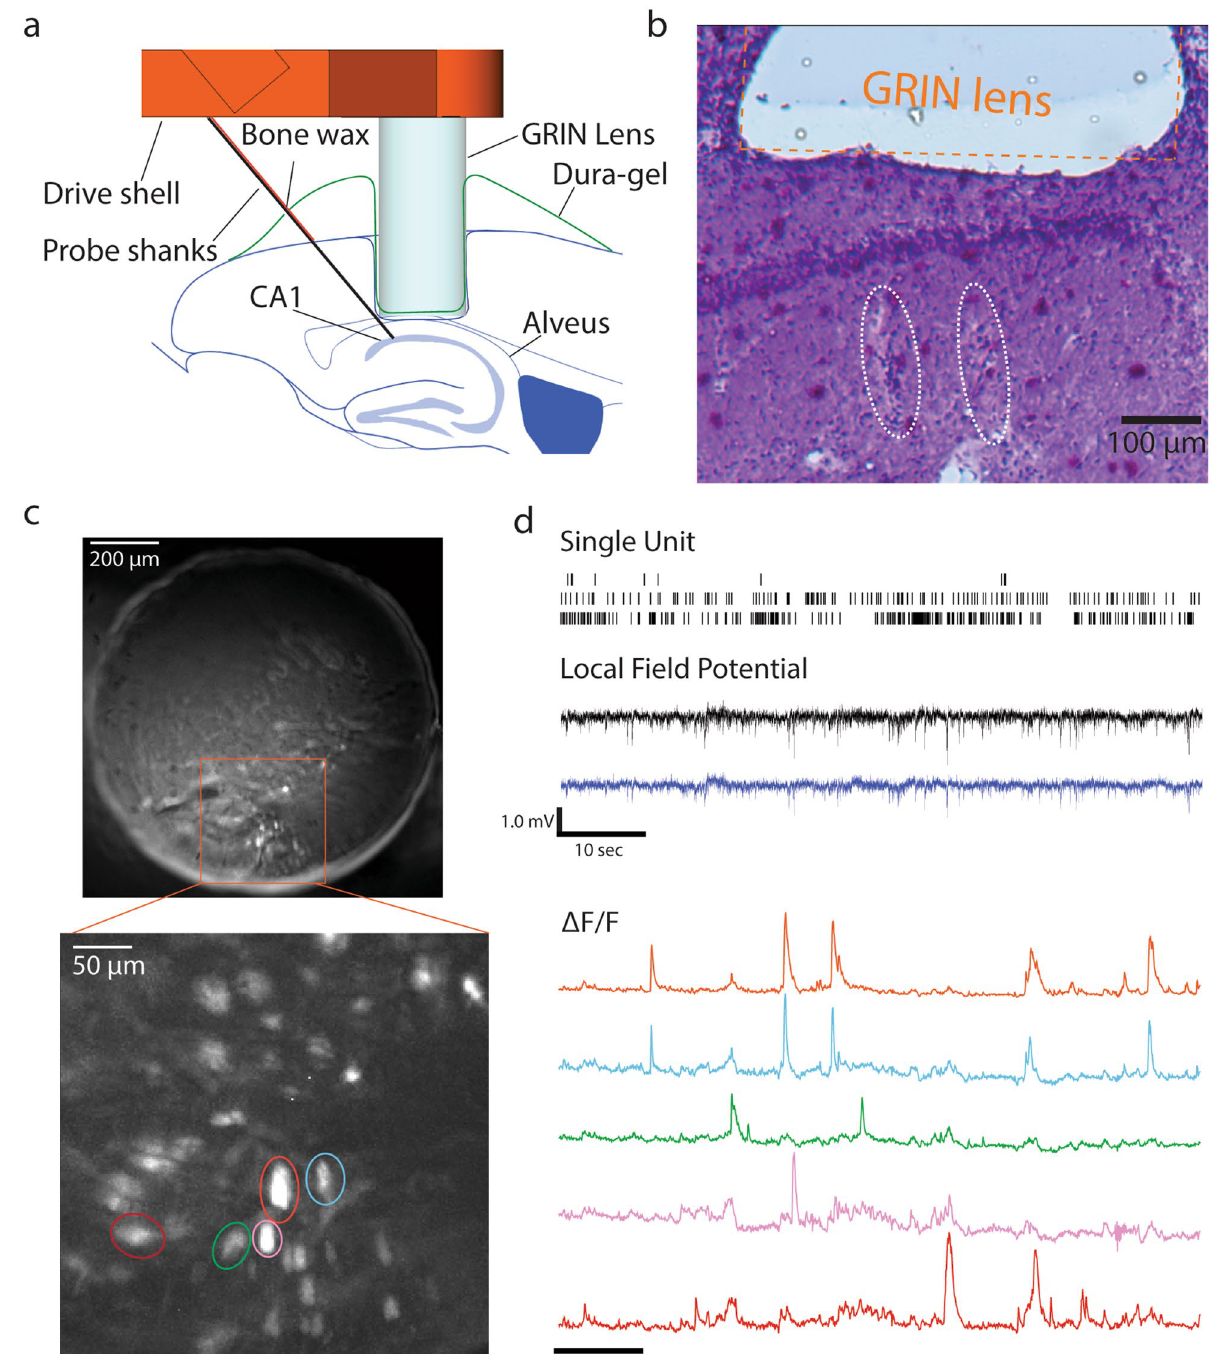
Figure 8. Bimodal recording of LFP, single unit activity and neuronal calcium signalling in the CA1 area using a 3D printed scaffold. ( a ) Diagram for the implanted positions of the 3D printed scaffold relative to the mouse brain. ( b ) An image of a cresyl violet-stained brain section showing the traces of the GRIN lens and two shanks of the silicon probe. Orange dashed line indicates the estimated edges of the implanted GRIN lens. Two traces of the shanks are indicated by white dashed ovals. ( c ) Top: A ΔF/F image of the entire GRIN lens in the scaffold. Bottom: A magnified ΔF/F image of the highlighted portion in the top image in the proximity of the tips of the recording probe. Individual cells are highlighted using coloured ellipses. ( d ) Top: Raster plots showing firing of three single units. Middle: Raw LFP signals from two different channels. Bottom: calcium signal traces of neurons highlighted by the same colors in the bottom image of ( c ). Data in ( c , d ) were recorded 4 weeks after